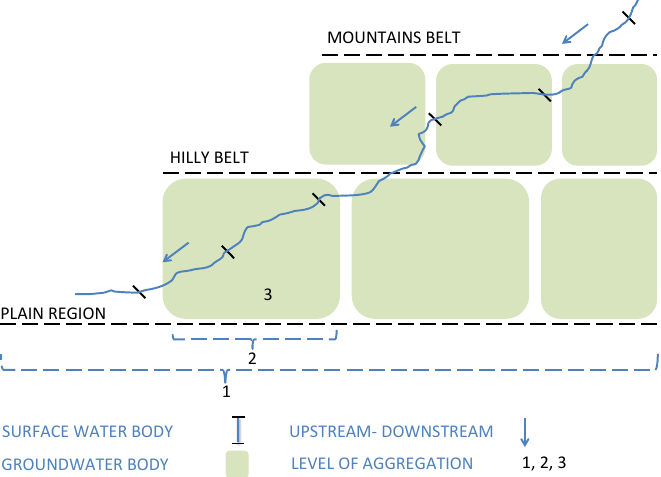
Figure 2. Levels of aggregation for ground and surface water bodies: mountain belt, hilly belt and plain